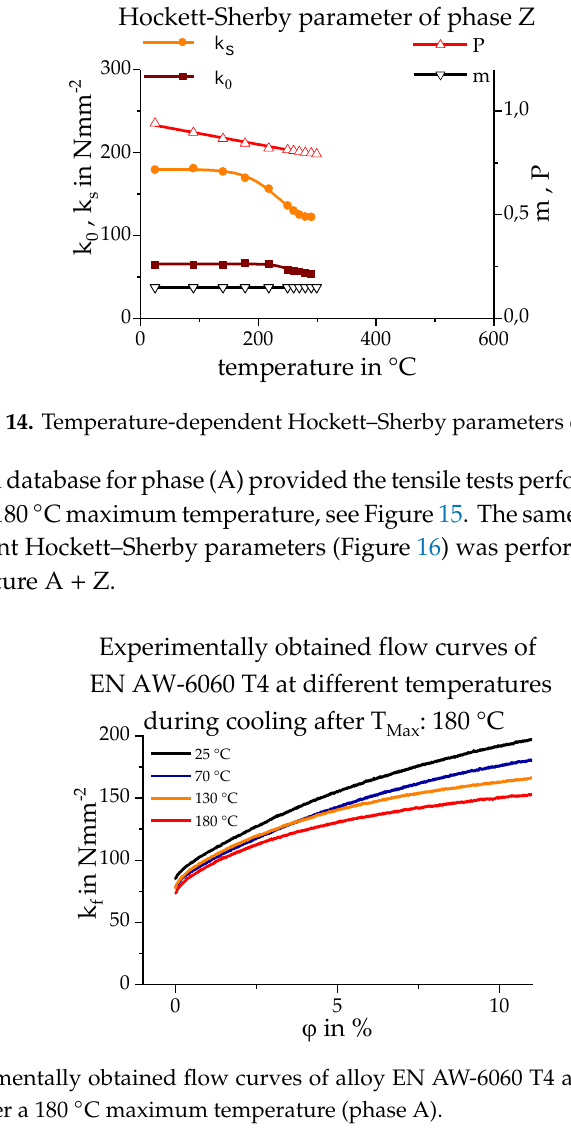
Figure 16. Temperature-dependent Hockett–Sherby parameters of phase (A).